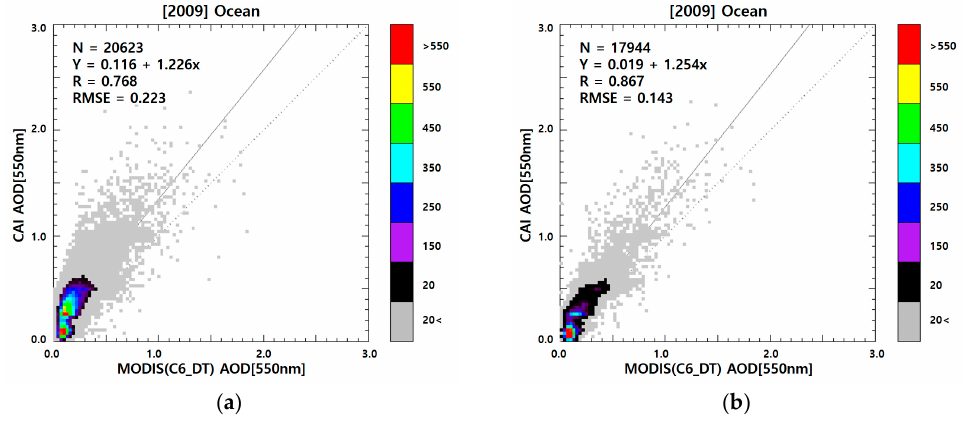
Figure 8. Comparisons of AOD retrieved from the TANSO-CAI aerosol algorithm with those from Aqua/MODIS (collection 6) over ocean ( a ) with RDFs by Kuze et al. [34]; ( b ) with RDFs by JAXA’s MODIS correction result from June to December 2009. The colored pixels represent a frequency number with a bin size of 0.03 AOD. The black solid and dashed lines are the linear regression and one-to-one lines, respectively.